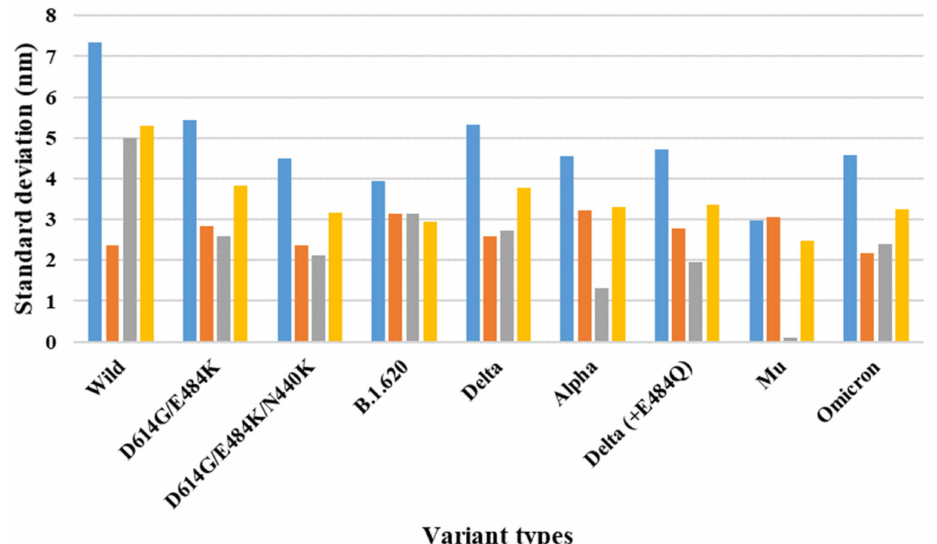
Figure 3. The standard deviation for the distance between V503 residues in each chain for the final MD trajectory in the two-open-complex form (7A97). The X axis denotes mutant types, and the Y axis denotes the standard deviation for distance (nm). Blue indicates the standard deviation between the AB and BC chains, orange indicates the SD between the AB and AC chains, gray indicates the SD between the AC and BC chains, and yellow indicates the SD among the A, B, and C